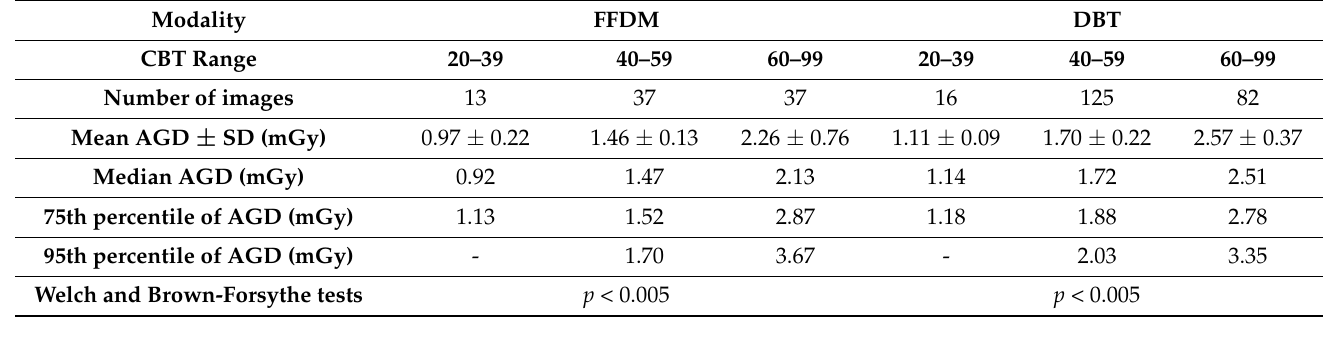
Table 6. The mean, median, 75th percentile, and 95th percentile of AGD per woman for each mammographic technique in different CBT groups.